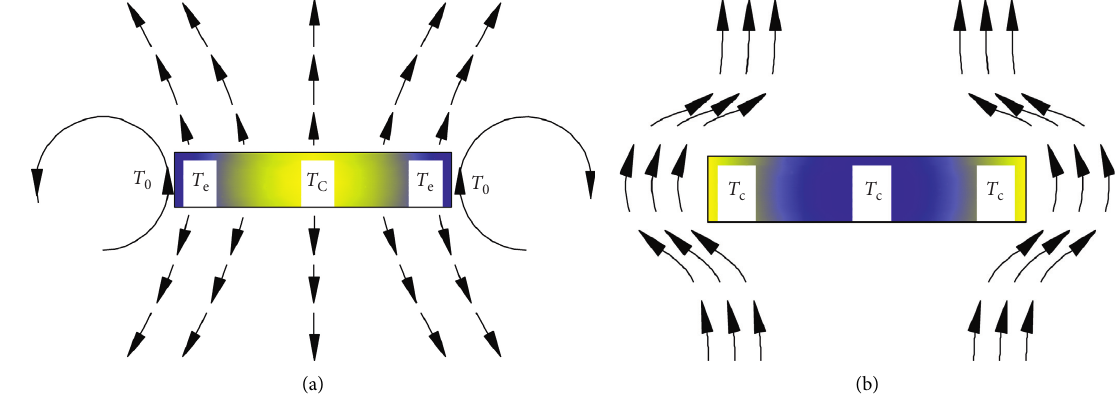
Figure 1: Air flow diagram of the magnesium alloy plate roller table. (a) Air flow diagram of the traditional conveying roller table. (b) Air flow diagram of the insulation conveying roller